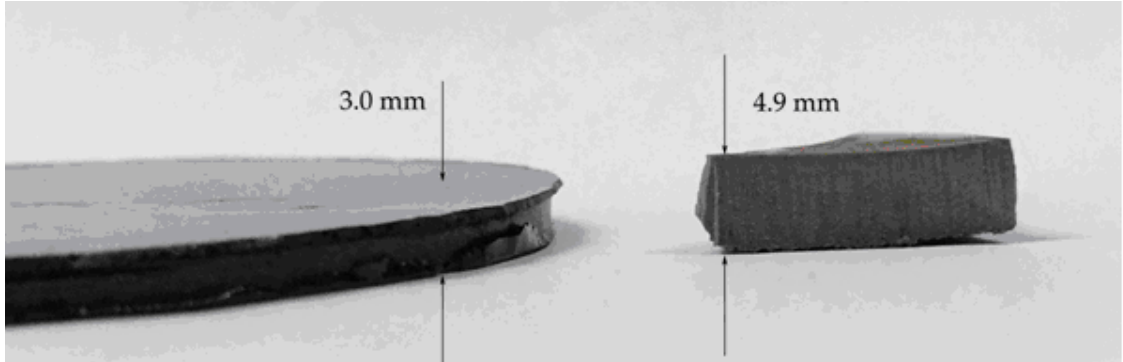
Figure 2. Digital photographs showing the sample before foaming (foam precursor, left ) and after foaming ( right ).